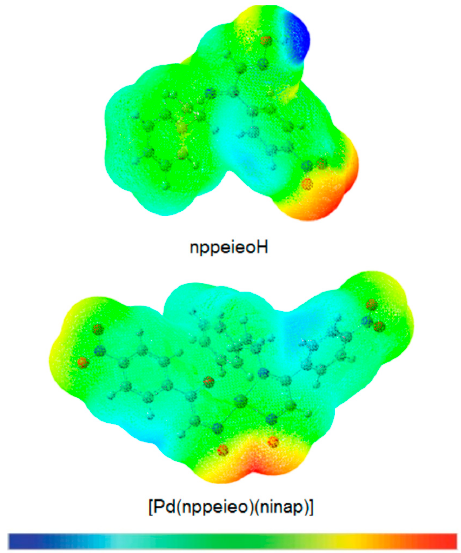
Figure 7. Molecular electrostatic potential (MEP) plot of nppeieoH and its palladium(II) complex.